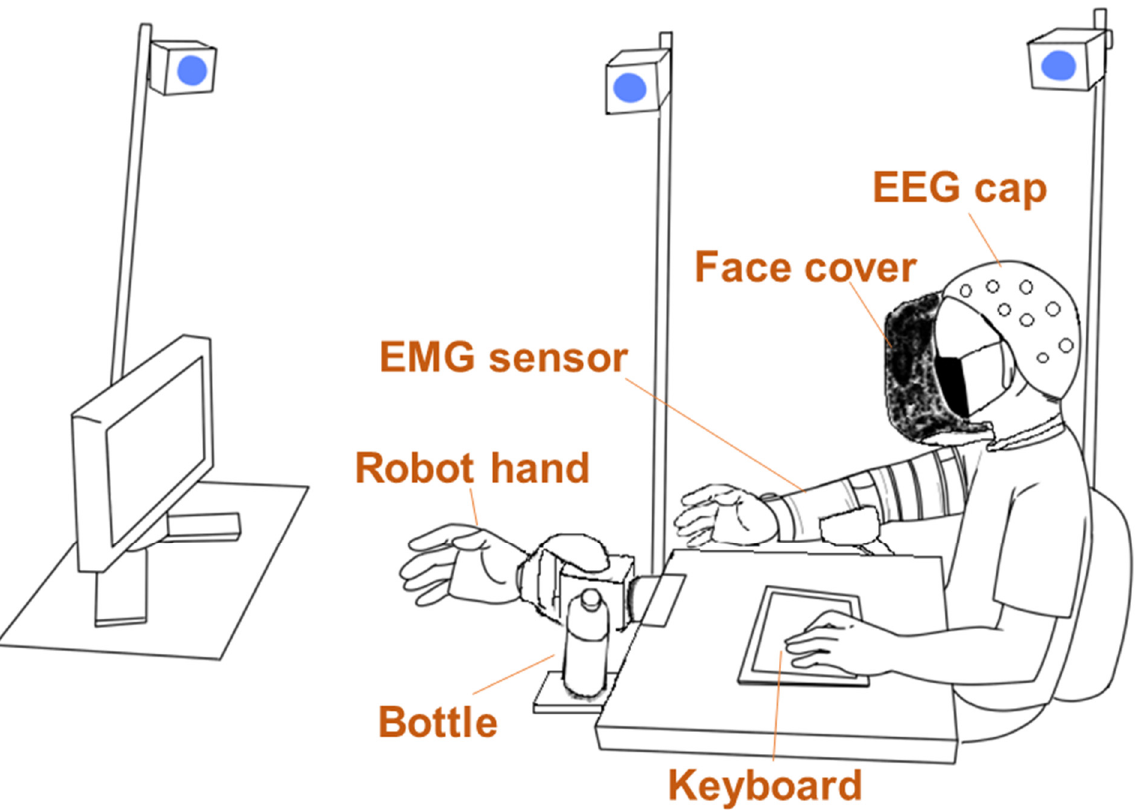
Figure 1. Experimental environment (not to scale). During the experiment, participants sat on a chair and placed their right arm on an armrest attached to the table. A keyboard was placed on the table through which participants responded to questions by pressing a button. For the task, participants were asked to grab a bottle, which was positioned such that the robot hand could be bent to grab the bottle. The robot hand could bend/extend a wrist and grip fingers with one degree of freedom (DOF). An opaque face cover prevented the participants from seeing their right arm. A monitor was placed in front of the table along the midline of the body, which includes a robot hand on the line to enable participants to easily see the screen.